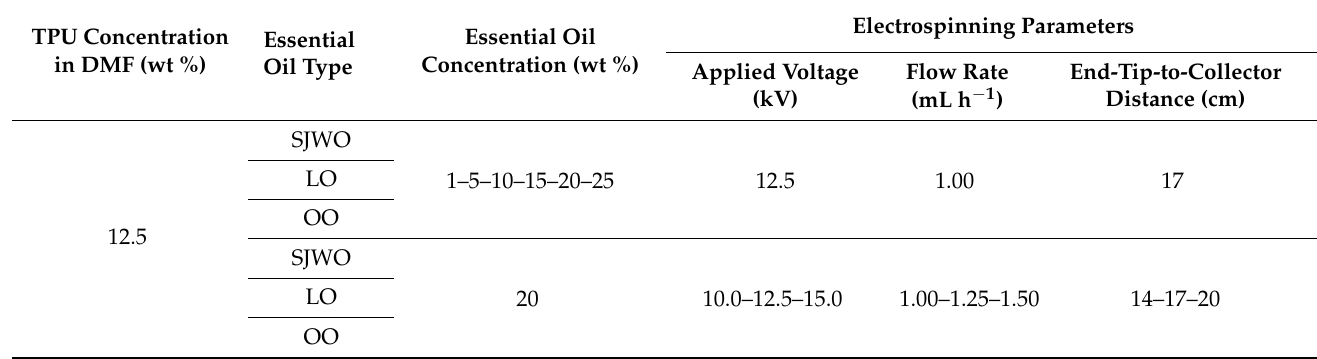
Table 1. The concentrations of the solutions and system parameter values.